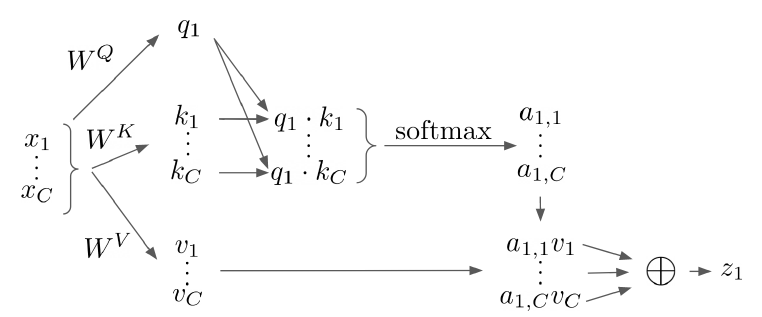
Figure 2: Illustration of scaled dot-product single-headed self-attention. All elements are defined in the